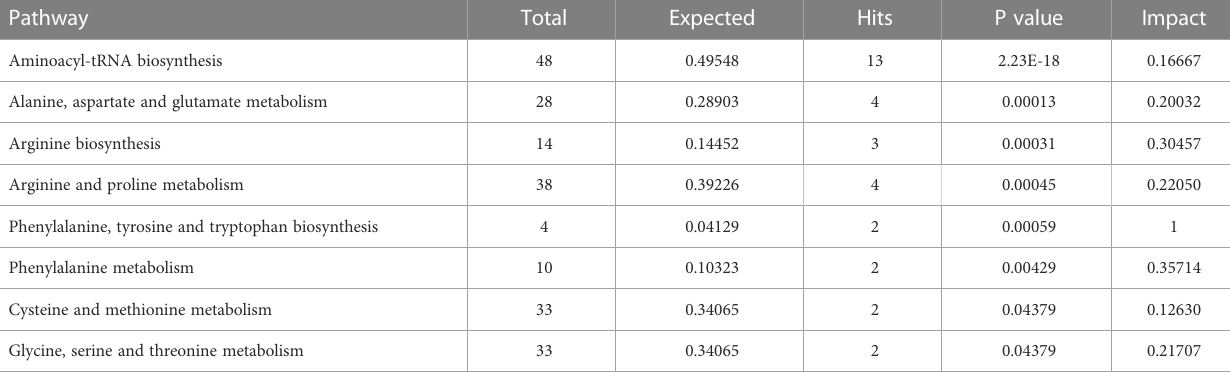
TABLE 4 Eight signi fi cant pathways between HUVEC and HemEC by targeted metabolic analysis.